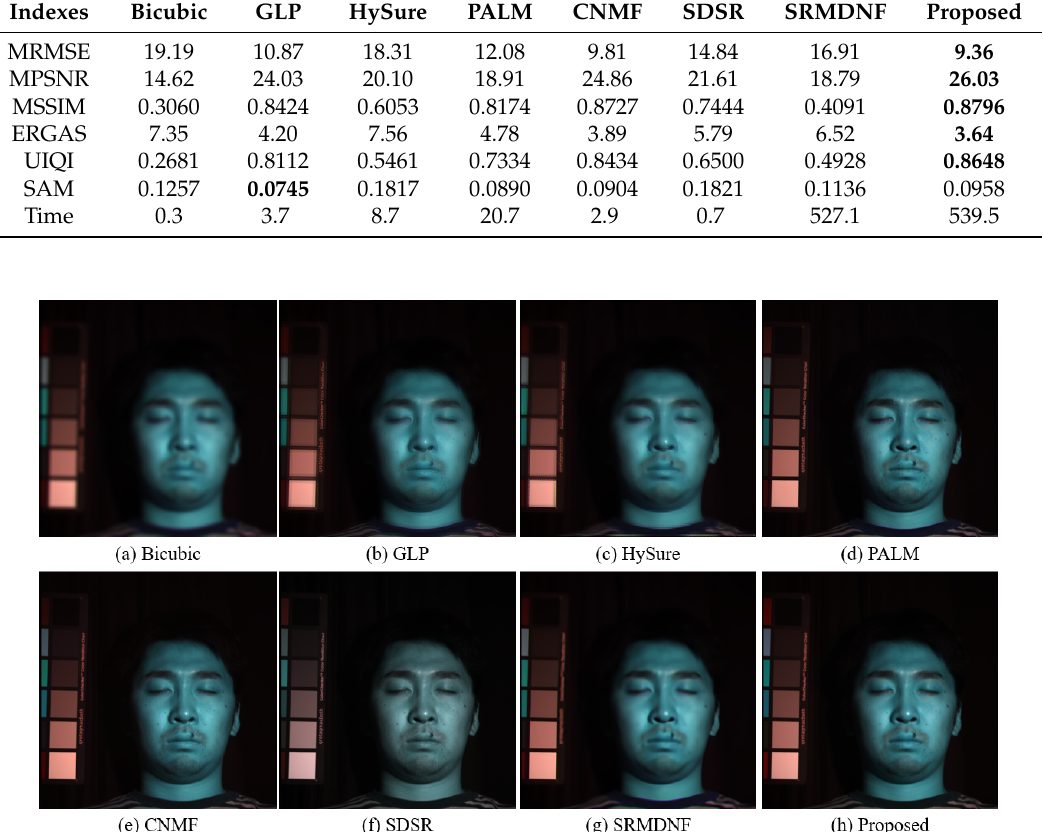
Figure 10. Super-resolution reconstruction results on the Face image from the CAVE dataset with a magnification factor of four. ( a ) Bicubic (MSSIM: 0.9205); ( b ) GLP (MSSIM: 0.9691); ( c ) HySure (MSSIM: 0.9427); ( d ) PALM (MSSIM: 0.9693); ( e ) CNMF (MSSIM: 0.9348); ( f ) SDSR (MSSIM: 0.9561); ( g ) SRMDNF (MSSIM: 0.9666); ( h ) proposed (MSSIM: 0.9782